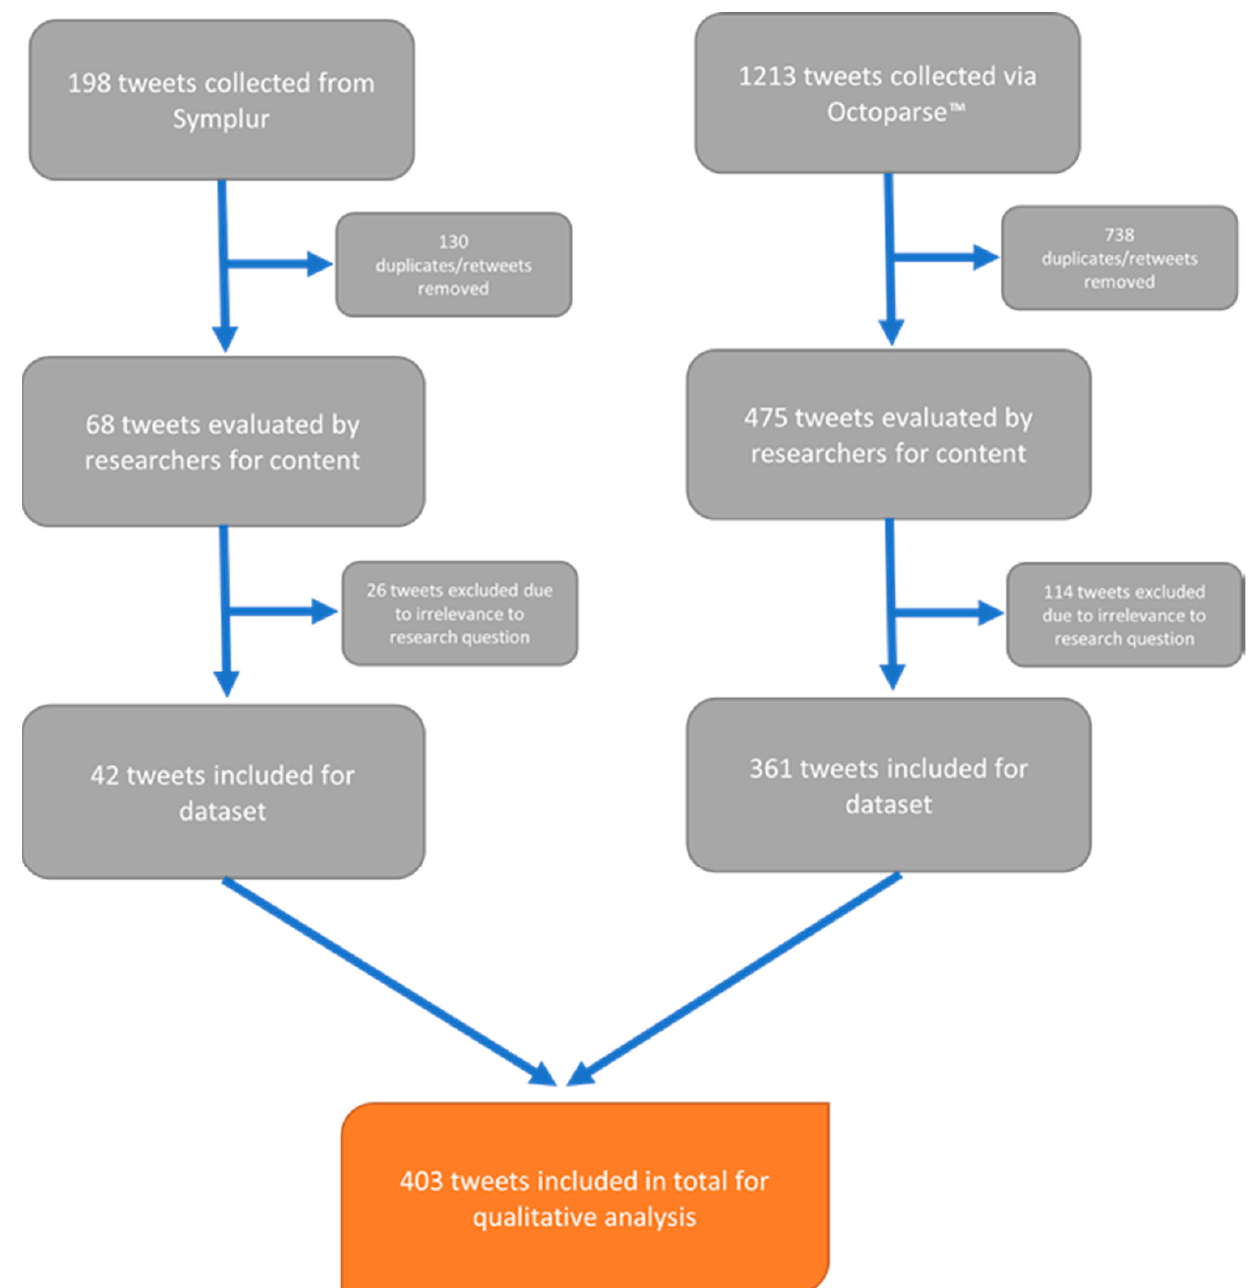
Figure 1. Inclusion and exclusion criteria used to aggregate the final dataset.